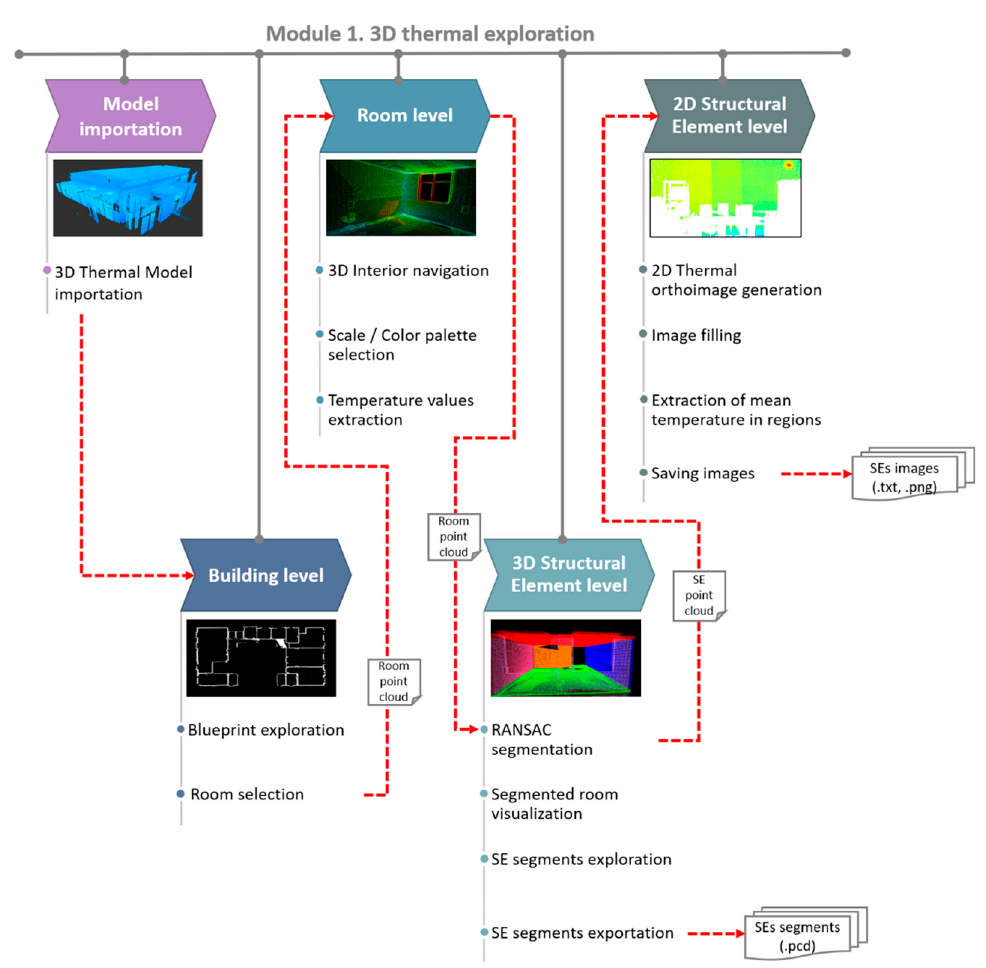
Figure 3. Diagram of the tools and functionalities of Module 1.